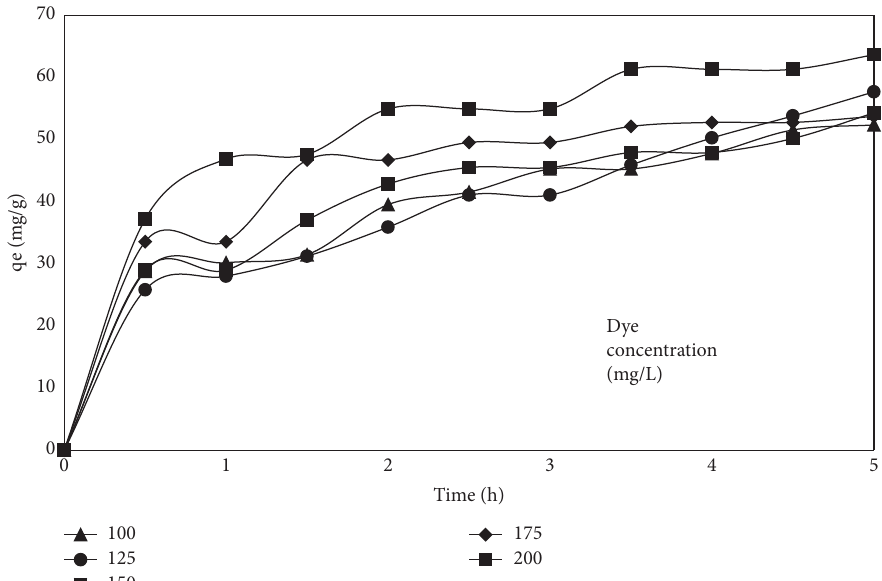
Figure 5: Efect of the initial concentration of the adsorbate on the MB adsorption using PVB/bentonite nanofbers at 27 ° C, pH 9, and 500rpm.